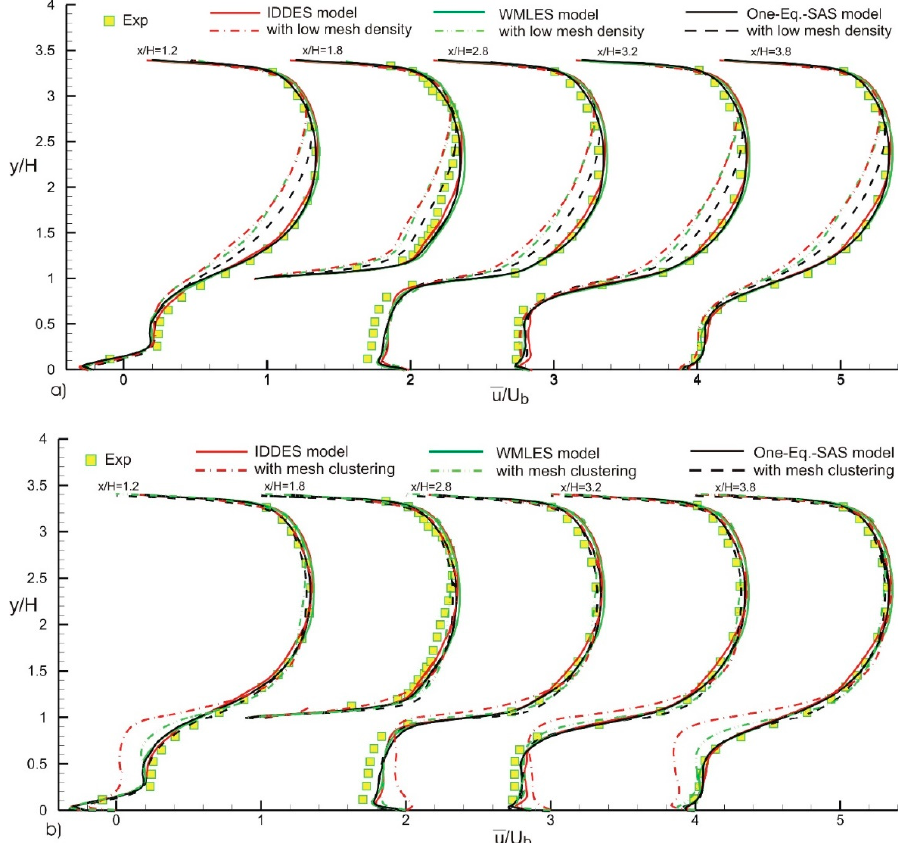
Figure 3. Effect of ( a ) mesh density, and ( b ) mesh clustering on the average streamwise velocity in the XY plane cutting through the center of the cube at z/H = 0. Each successive x/H profile starting from the one at x/H =1.2 is offset by one unit from the previous profile.